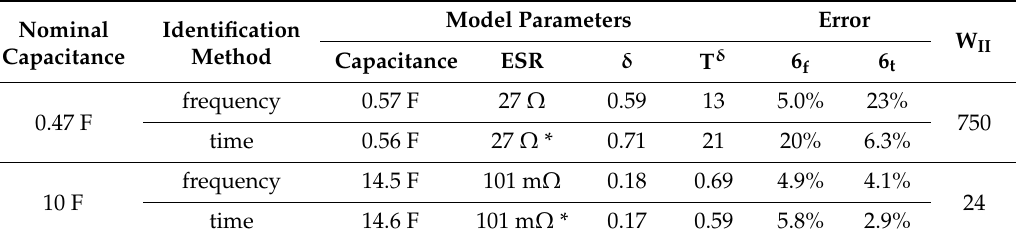
Table 1. The comparison of SC